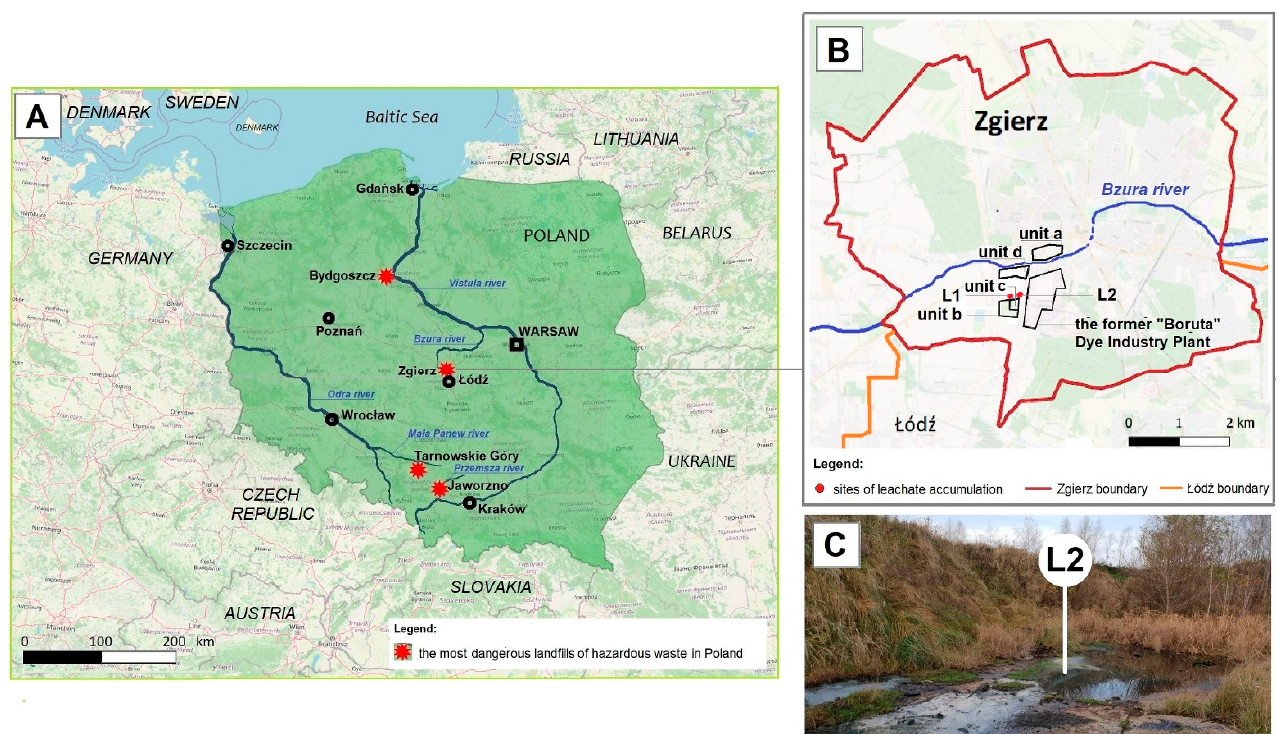
Figure 1. The most dangerous sources of industrial pollution in Poland ( A ) and location of the study region—the area of the former “Boruta” Dye Industry Plant and the landfill ( B , C ). The main parameters of the leachates L1 and L2 that accumulate at the base of the landfill slope in the last years (2017–2021) are presented in Table 1. Throughout the peri- (TOC) were slightly and greatly higher, respectively, than the limits specified in the ap-